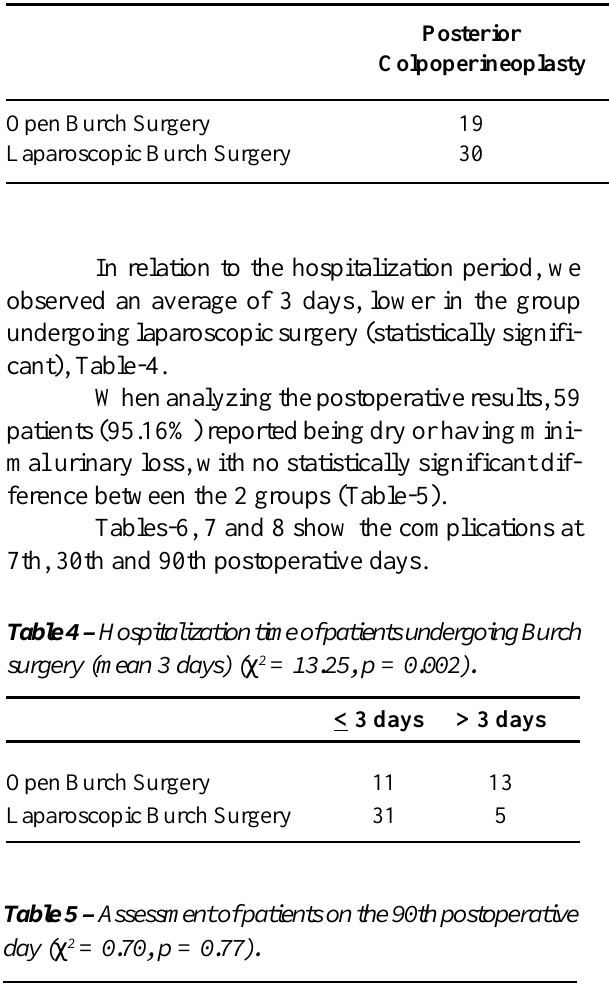
Table 3 – Types of surgical procedures associated with Burch surgery.